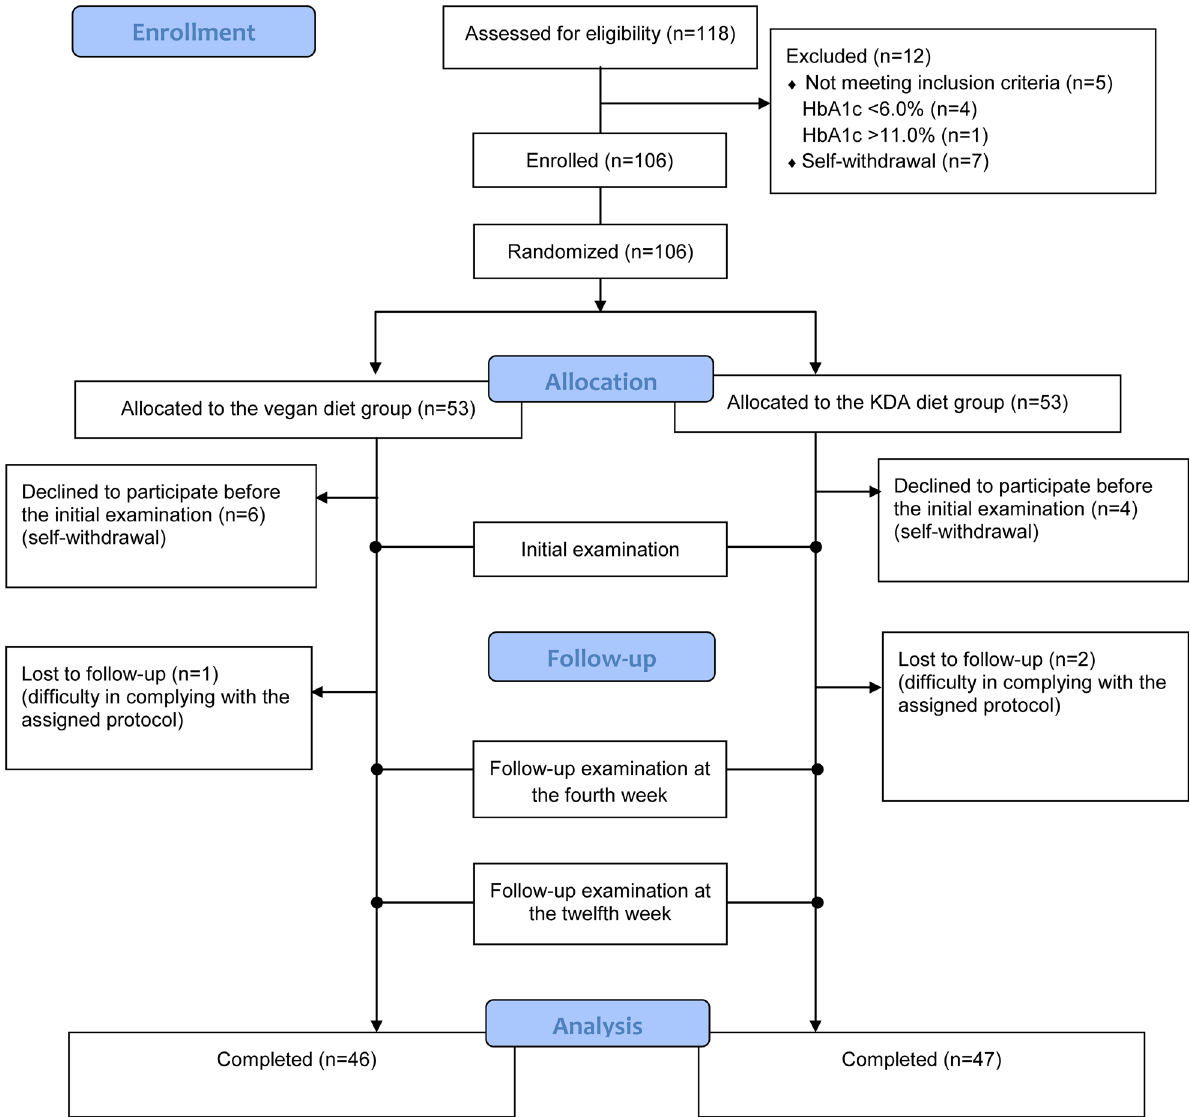
Fig 1. Enrollment of participants in the